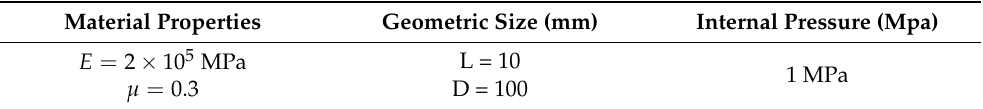
Table 4. The model calculation example parameters.